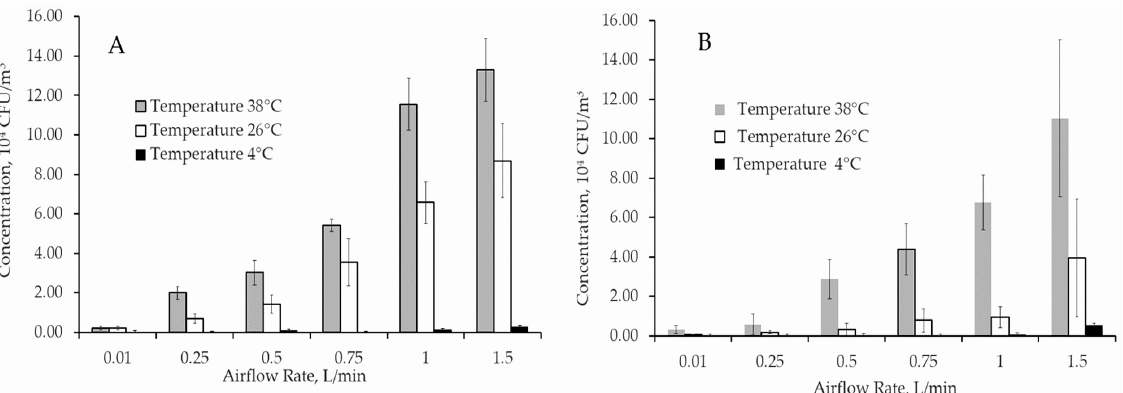
Figure 4. Bioaerosol concentration at different temperature of the microbial suspension. ( A ) Small bubbles and ( B ) large bubbles. The error bars represent STDEV of at least three experimental runs.